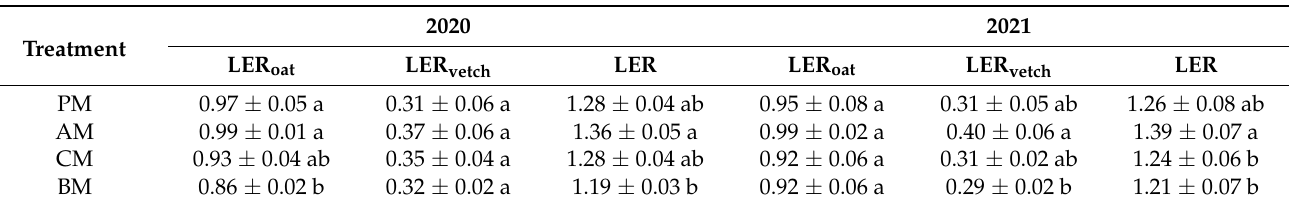
Table 6. Land equivalent ratio of mixed cropping system among different cropping systems over two years in Yanchi county, Ningxia, China.